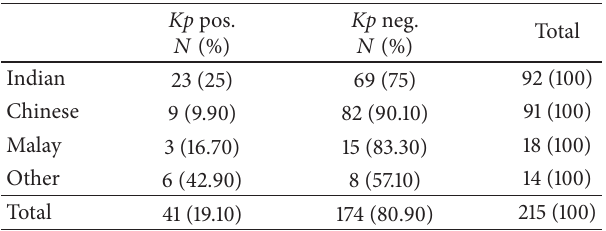
Table 6: Prevalence of Klebsiella pneumoniae according to ethnic group.